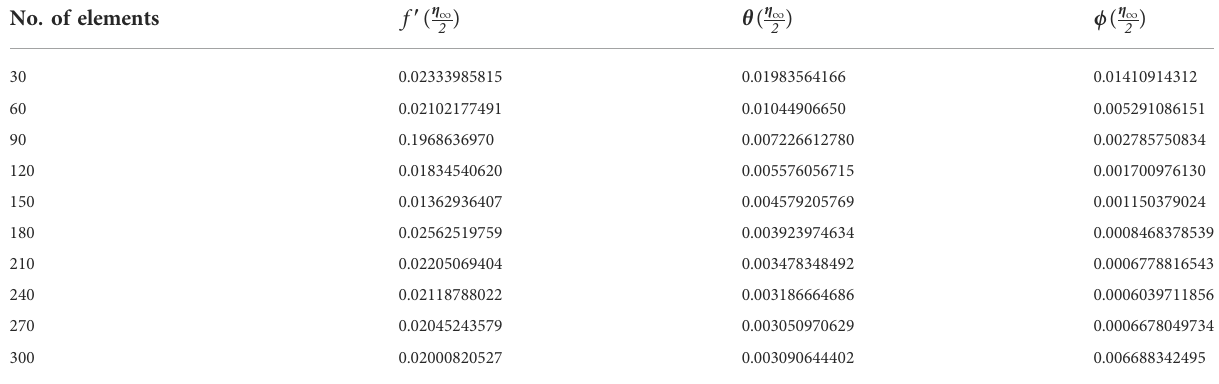
TABLE 2 Mesh-free study for concentration, velocity, and temperature fi elds predicted by 300 elements.